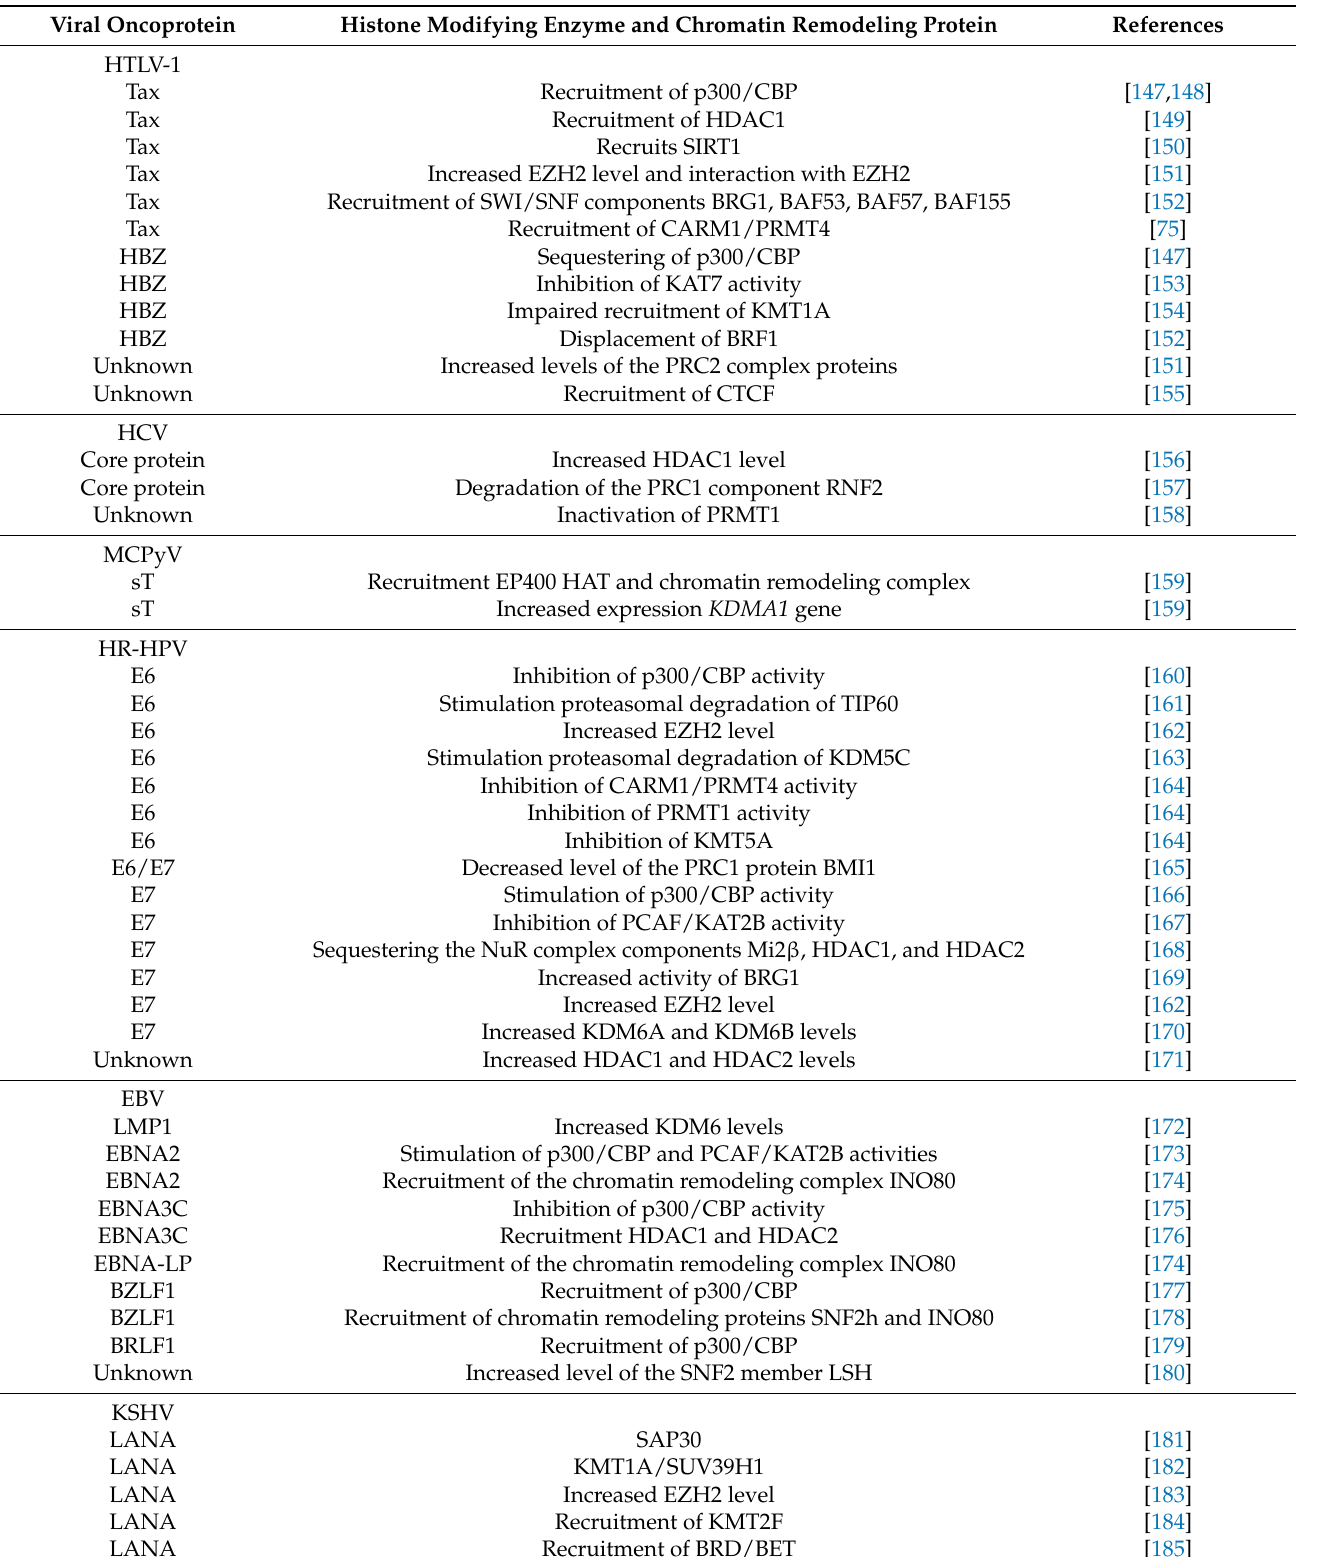
Table 2. Effects of viral oncoproteins on histone modifying enzymes and protein chromatin remodeling complexes. See text for